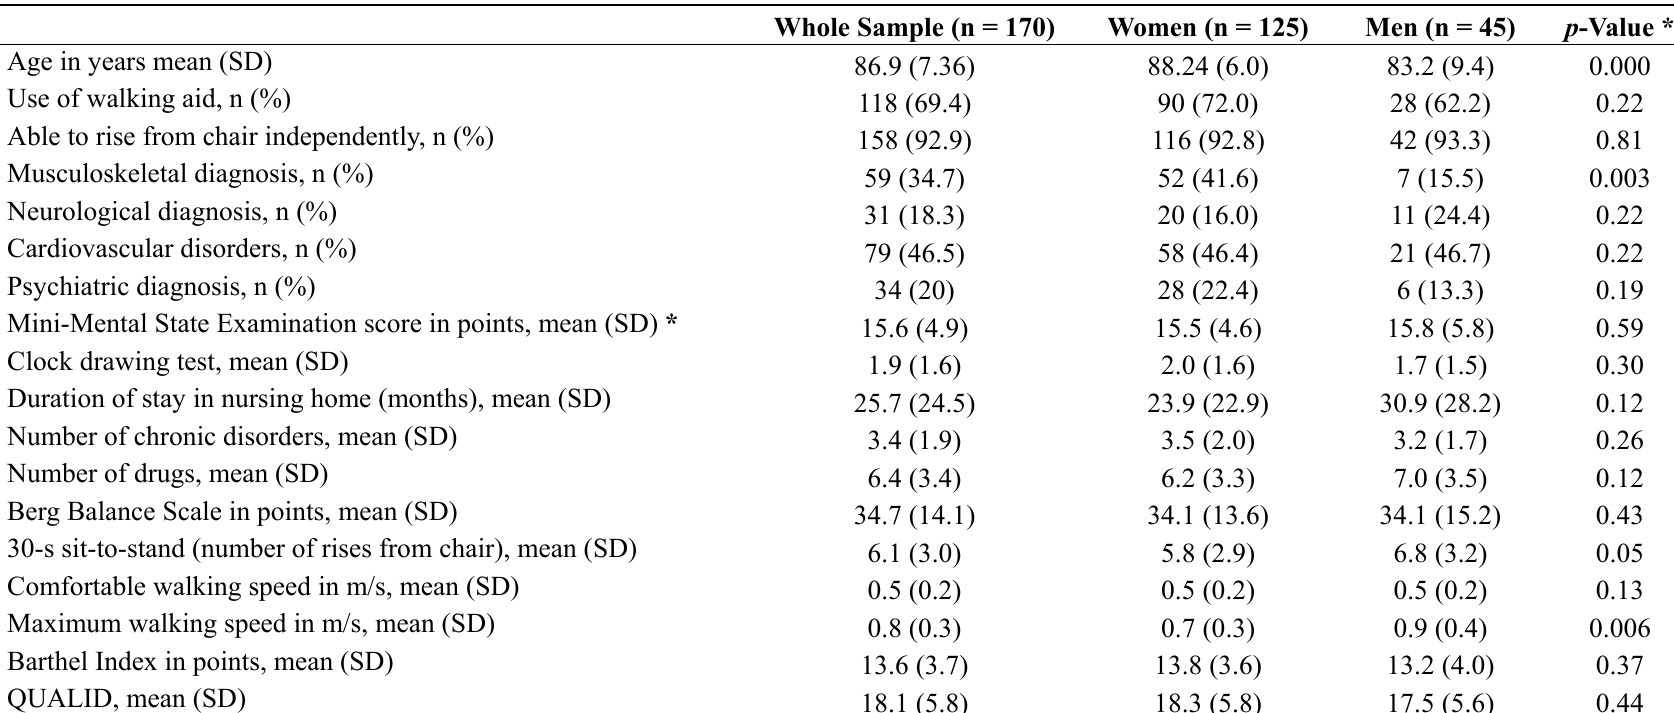
Table 1. Characteristics of demographic data, health and physical function variables for whole sample and according to